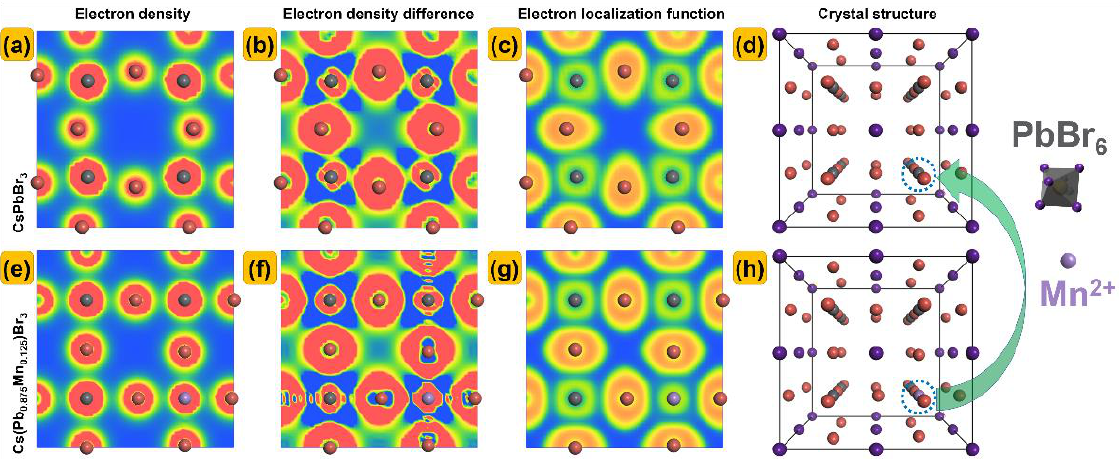
Figure 4. ( a , e ) Electron density, ( b , f ) electron density difference, ( c , g ) electron localization function and ( d , h ) crystal structure of CsPbBr 3 and Cs(Pb 0.875 Mn 0.125 )Br 3 .